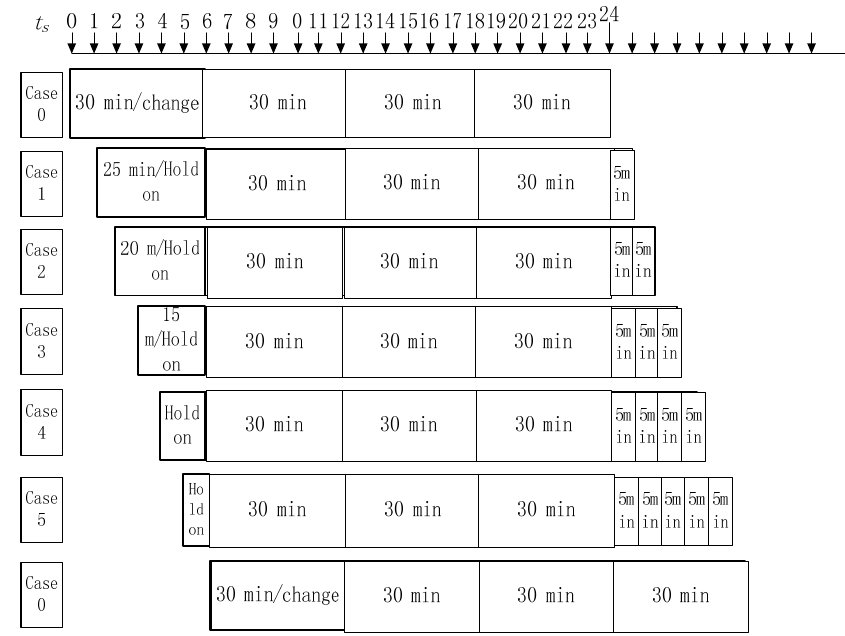
Figure 5. Single-level MPC performing rolling optimization (based on pumped storage and fly